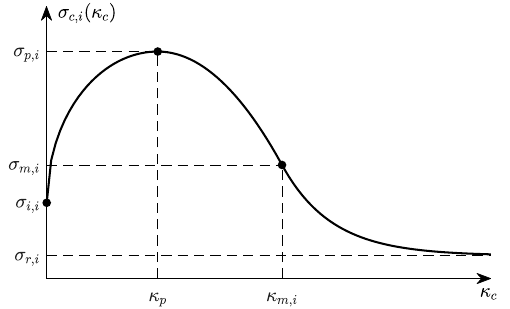
Figure 1. Hardening/softening law for the compres- sive yield